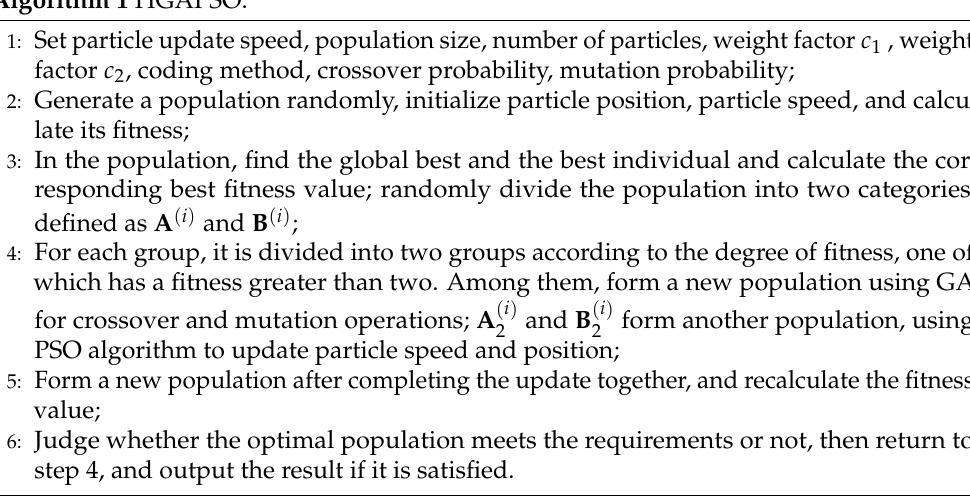
Figure 5. Optimization process of the HGAPSO algorithm. The specific optimization steps of HGAPSO are shown in Algorithm 1. Algorithm 1